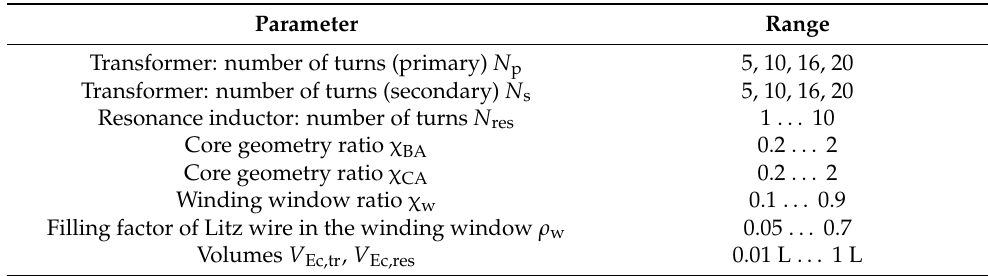
Table 7. Tuning parameters for a loss-optimized design of the hf transformer and resonance induc- tor.